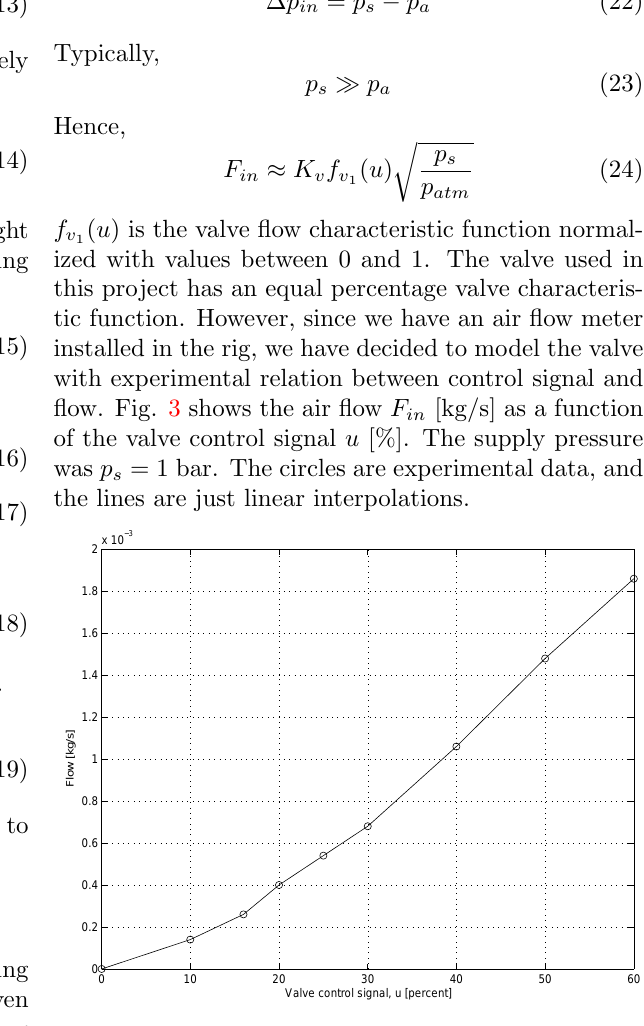
Figure 3: Air flow F in [kg/s] as a function of the valve control